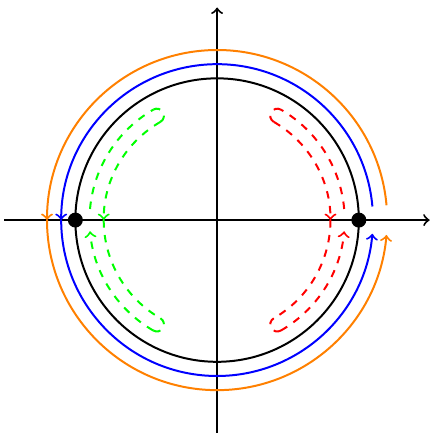
Figure 2 . Typical Euclidean time development along the equator θ = π/ 2 of the Bloch sphere. The blue-solid and orange-solid curves are homotopically non-trivial modes, while the green-dashed and red-dashed curves are homotopically trivial modes. Each type of the solid/dashed curves corresponds to the ones in figure 1. The two blobs correspond to the two domain